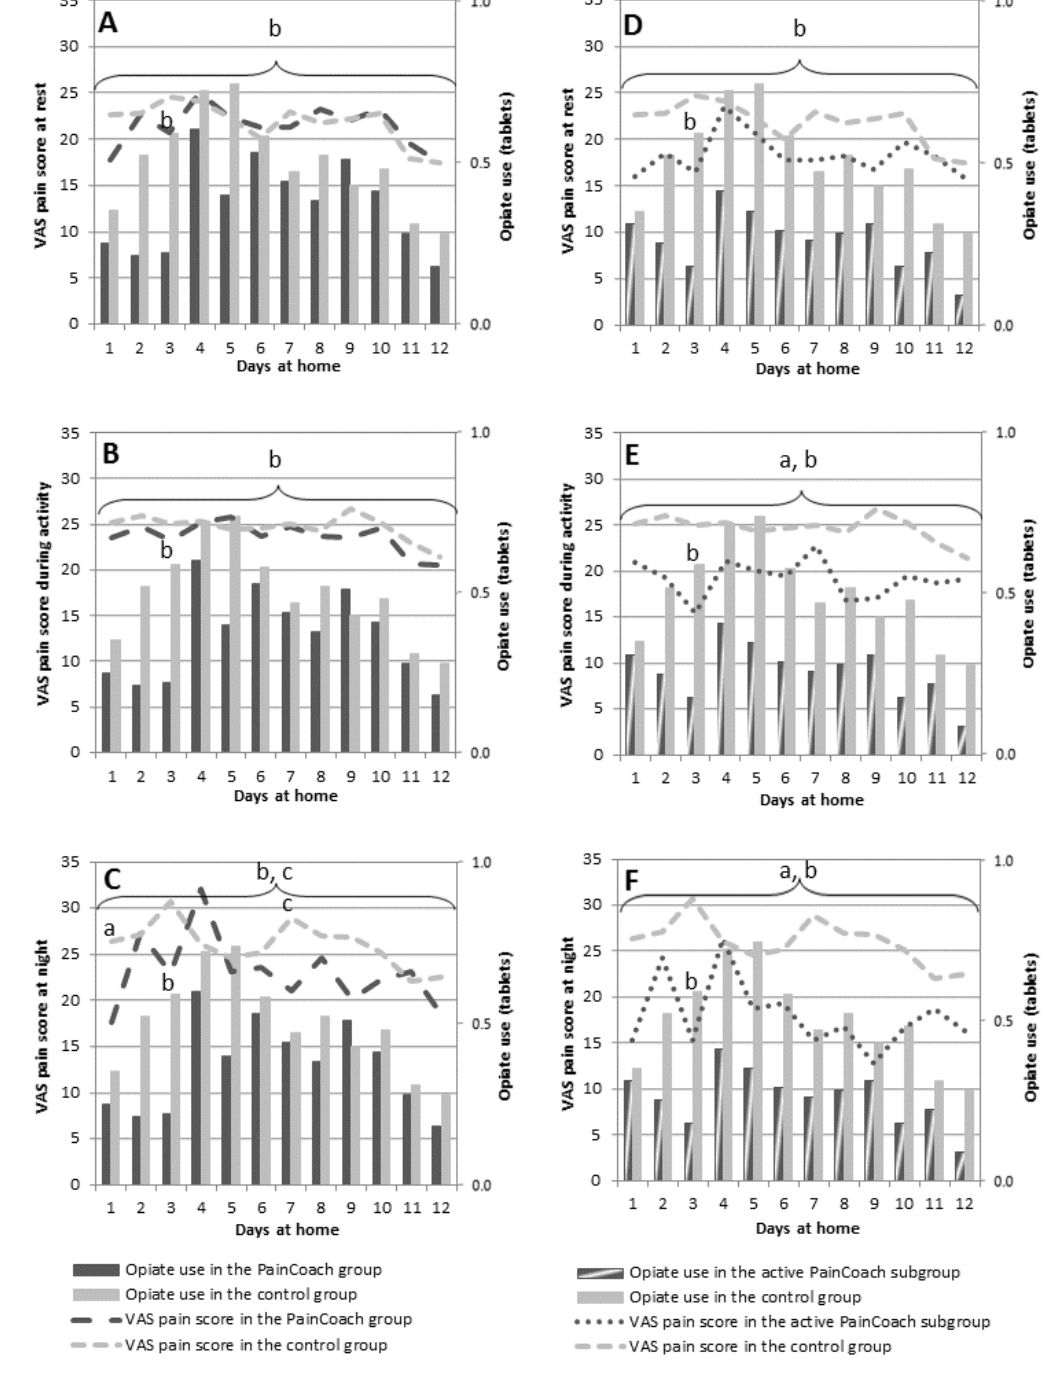
Figure 2. VAS pain scores and opiate use in the PainCoach group and control group at rest (A), during activity (B), and at night (C) and in the active PainCoach subgroup and control group at rest (D), during activity (E), and at night (F) on separate days and in the overall first period at home. a: significant difference in VAS pain ( P <.05); b: significant difference in opiate use ( P <.05); c: trend in VAS pain (.05< P <.10); VAS: visual analog